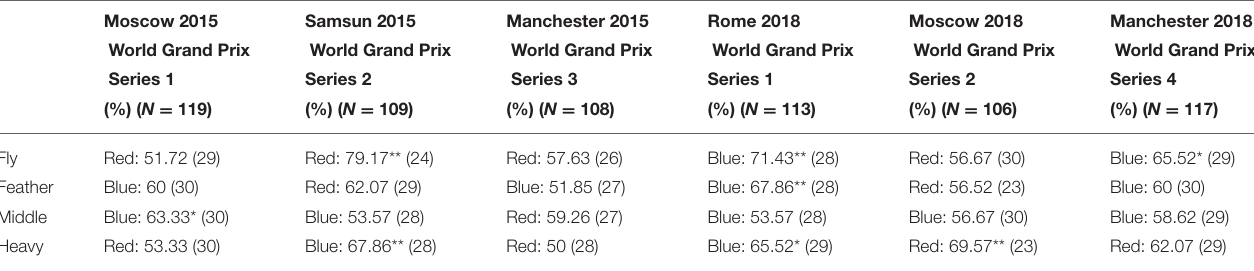
TABLE 3 | Percentage of matches won by male athletes according to their color protectors, edition, and weight